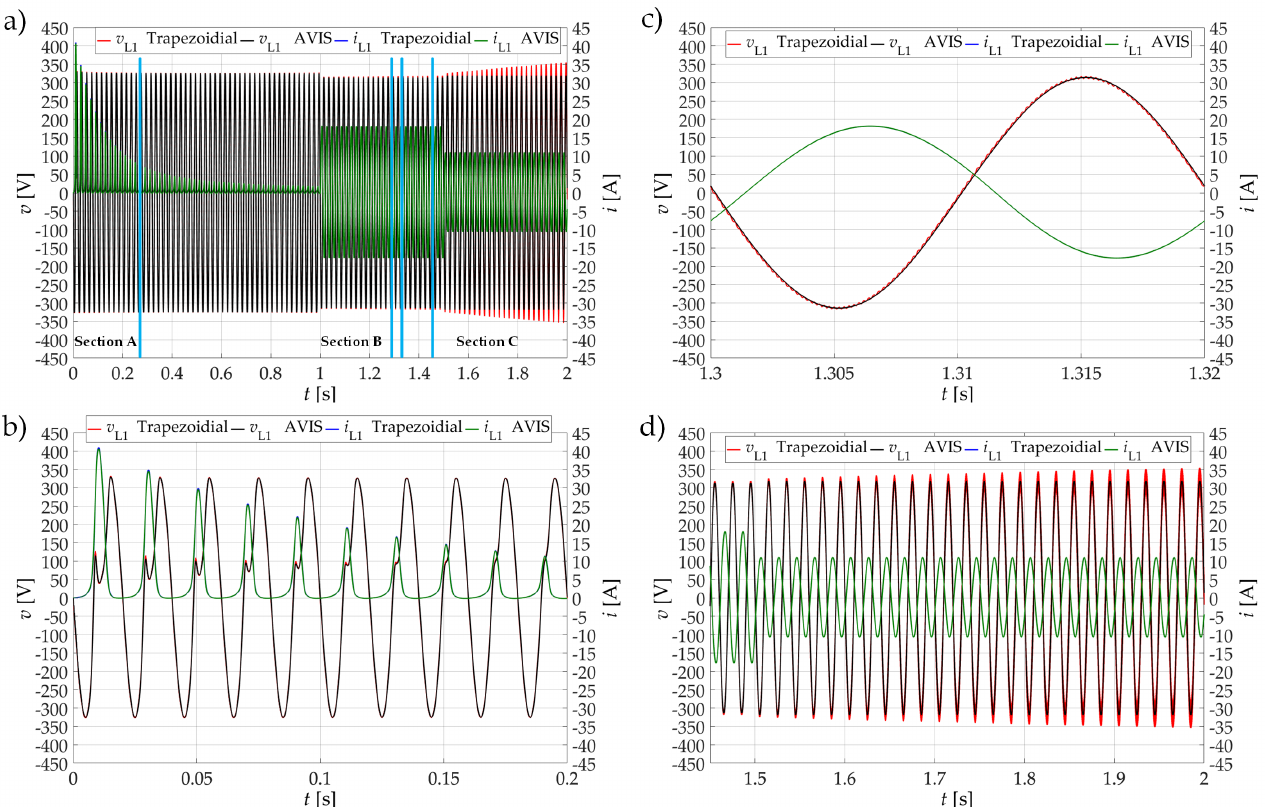
Figure 10. Time waveforms: ( a ) voltage in phase L1 and phase current in winding of phase L1 of a power transformer using the trapezoidal method and the AVIS method (three sections with details have been marked: ( b ) section A, ( c ) section B and ( d ) section